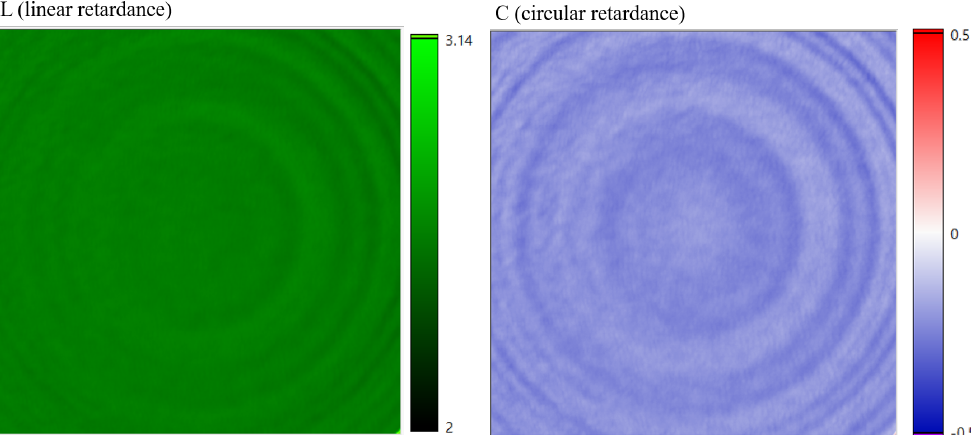
Figure 5. Magnitude values of linear and circular retardance in the central part of the lens (imaged area of 620 µ m by 620 µ m). The scales are given in